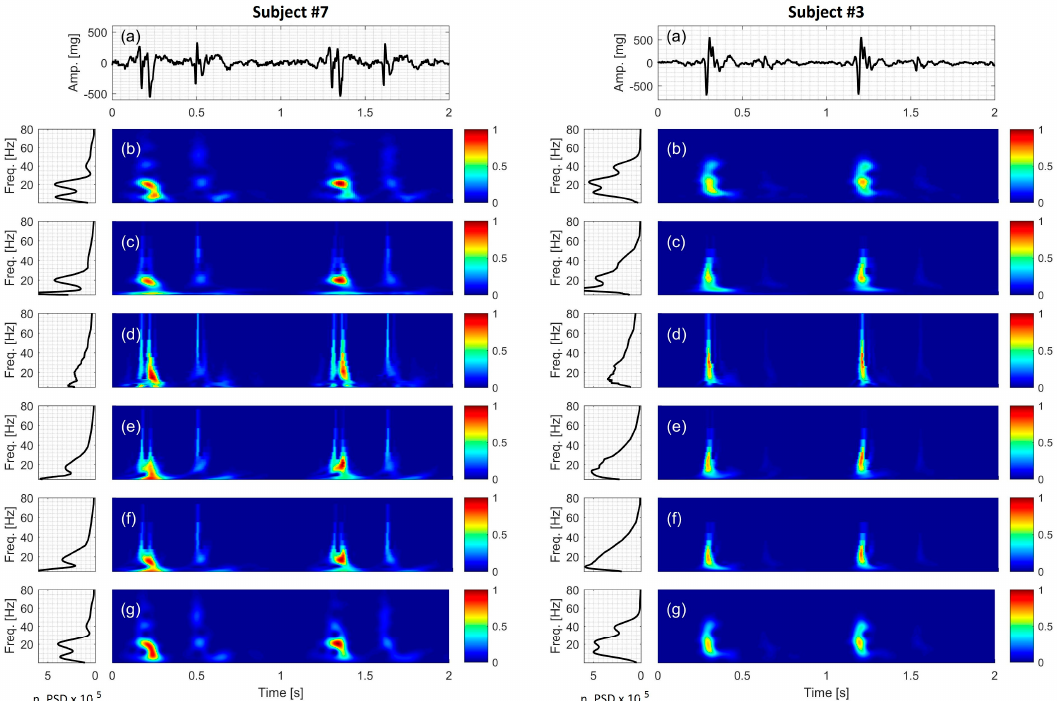
Figure 10. Actual SCG signal of two healthy subjects: (Left two columns) subject #7 (Right two columns) subject #3. For each subject ( a ) Time series. The time-frequency distribution using: ( b ) STFT; ( c ) CWT-Morl; ( d ) CWT-Haar; ( e ) CWT-db4; ( f ) CWT-Coif5; and ( g ) PCT is also shown. The power spectral density for each TFD is shown to the left of the distribution. Table 5. Dominant frequencies of the actual SCG signals calculated using polynomial chirplet transform. The most dominant frequency for each subject is highlighted in bold.